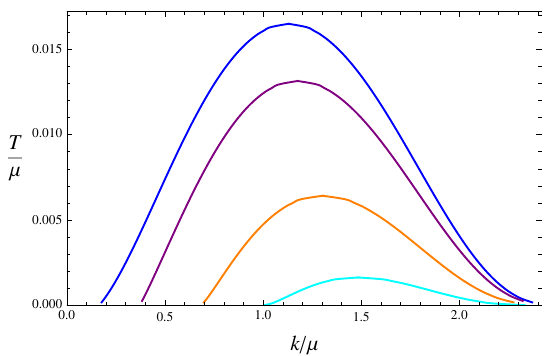
Figure 14 . Critical temperature versus wave number for the onset of striped instabilities in the presence of axions. We have m 2 = (cid:0) 8 ; m 2 = 0 ; L = 1 = 2 ; a = 4 ; (cid:20) = q A = 1, and from top to v